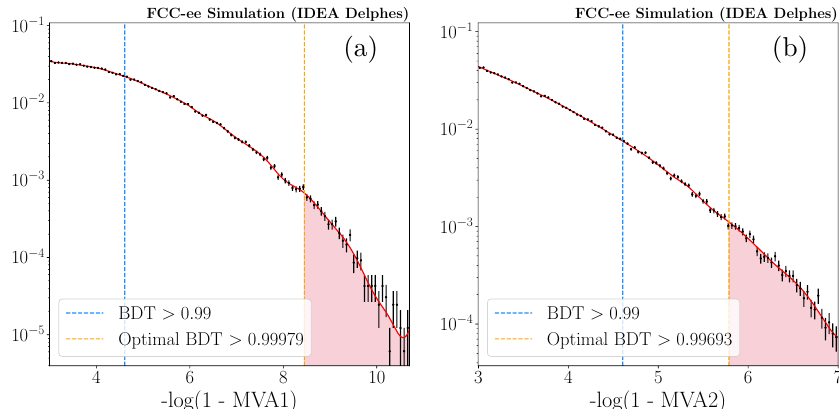
Figure 4 . (a) BDT1 distribution above 0.95 for a combined sample of exclusive b -hadron decays. (b) BDT1 distribution above 0.95 for a combined sample of exclusive b -hadron decays. The cubic spline parameterisations are shown by solid red lines, example cuts of BDT > 0 . 99 by the dashed blue lines, and the optimal BDT cuts by the dashed orange lines. The background efficiency given prior cuts of > 0 . 95 on both BDTs is given by the product of the spline integrals above the optimal cuts (red areas), where each integral is normalised to the respective spline integral across the full